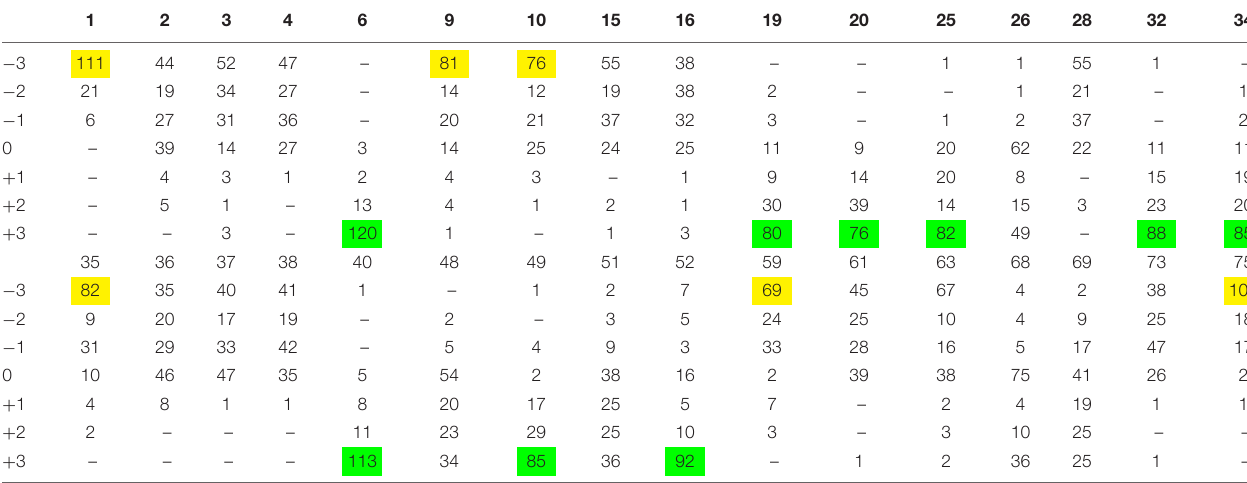
TABLE 3 | Number of athletes who have chosen each negative, neutral, or positive dimension of the 32 situations (in yellow the negatives, and in green the positive situations chosen by 50% or